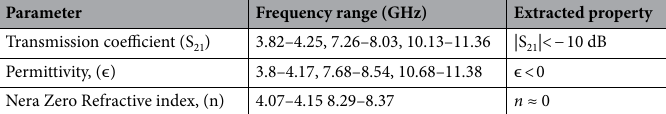
Table 3. Response of S21, permittivity, and refractive index of the structure.